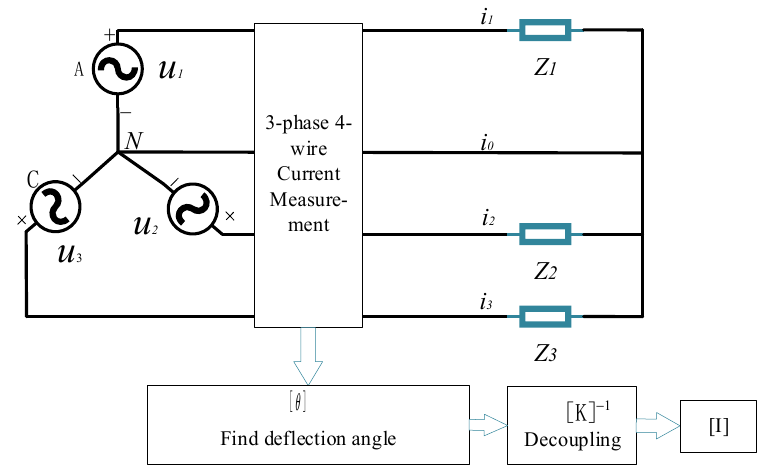
Figure 11. Three-phase current measurement method.